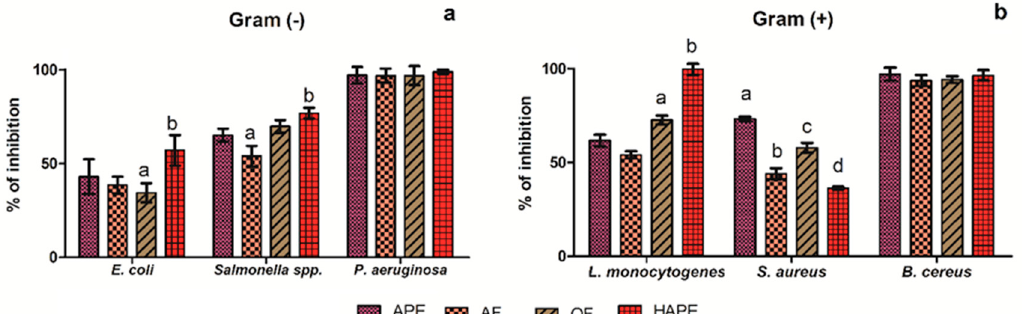
Figure 2. Screening Inhibitory Activity (%) of avocado peel extract and its fractions at 500 µ g/mL. a—Gram-negative ( − ) bacteria: Escherichia coli (E. coli) ; Salmonella spp.; Pseudomona aeruginosa ( P. aeruginosa ); and b—Gram-positive (+): Listeria monocytogenes ( L. monocytogenes ); Staphylococcus aureus ( S. aureus ); Bacillus cereus ( B. cereus ). Avocado peel extract (APE); organic fraction (OF); aqueous fraction (AF); acid-microwave hydrolyzed avocado peel extract (HAPE). Different letters on the bars between each bacteria strain represent significant differences according to the Tukey test ( p < 0.05).